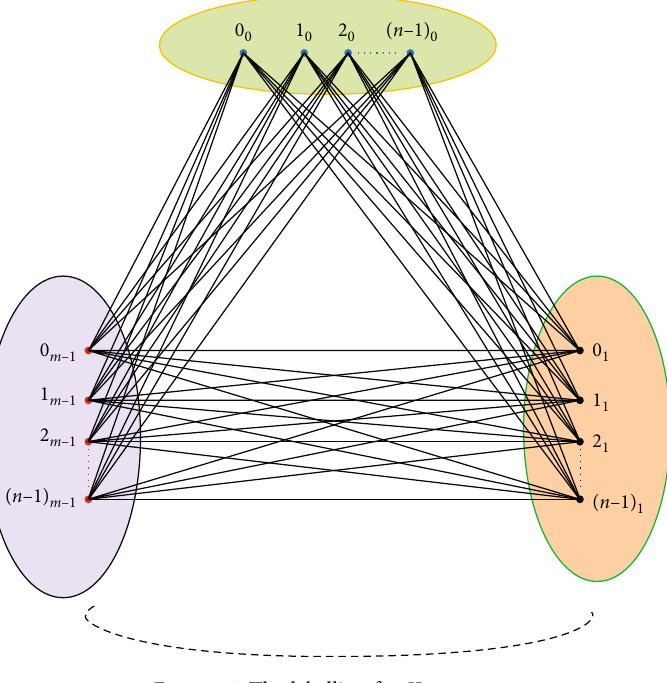
Figure 1: The labelling for Kn